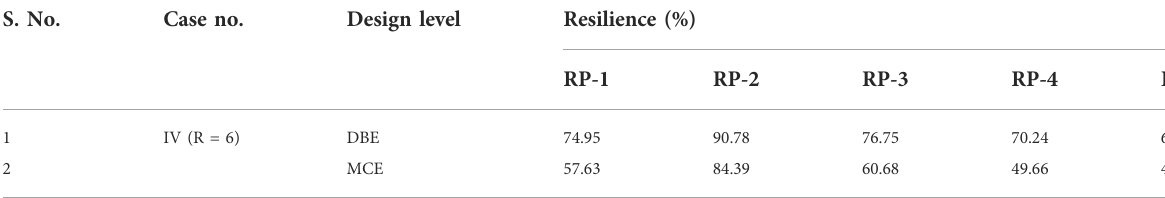
TABLE 12 Variation in resilience at each design level for case IV building. S.